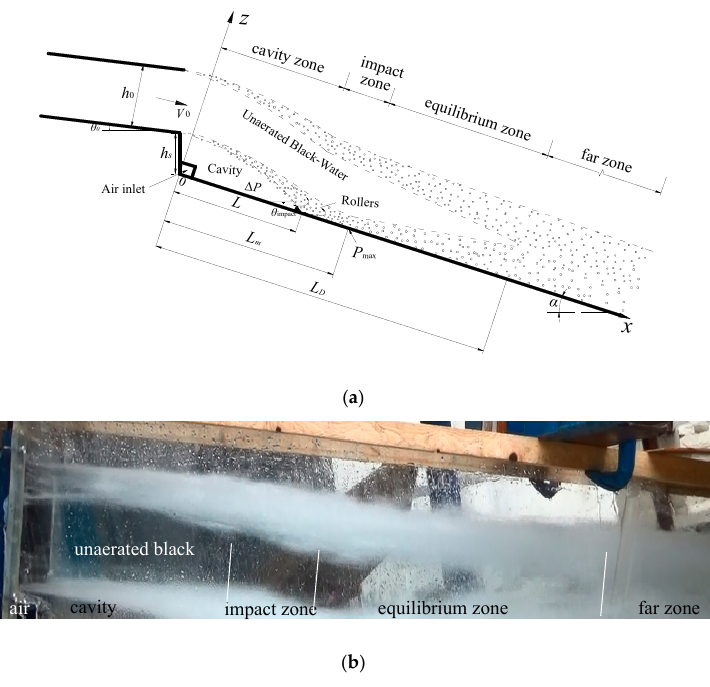
Figure 1. Definition sketch with relevant parameters ( a ) and side view of chute aerator flow with high speed camera ( b ). Table 2. Experimental conditions of chute aerator flow.